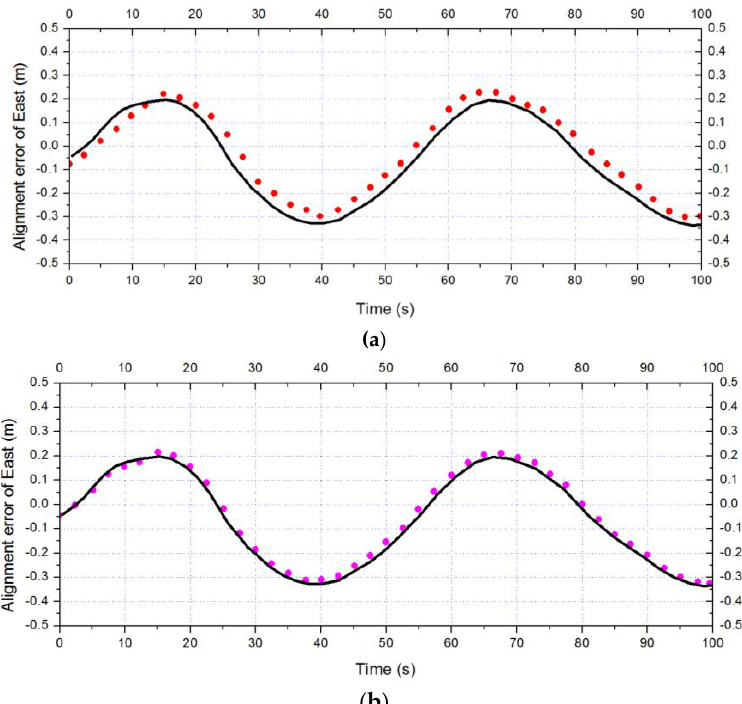
Table 2. Time delay calibration times using ICP-ISPKF for LiDAR-IMU. Time Delay Calibration Times Using